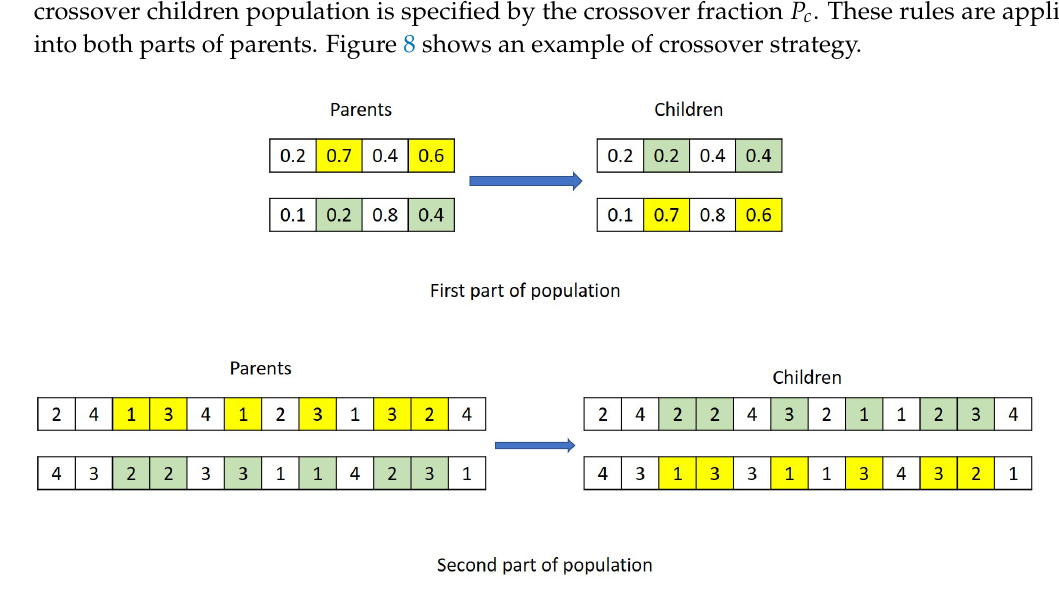
Figure 8. An example of crossover strategy.